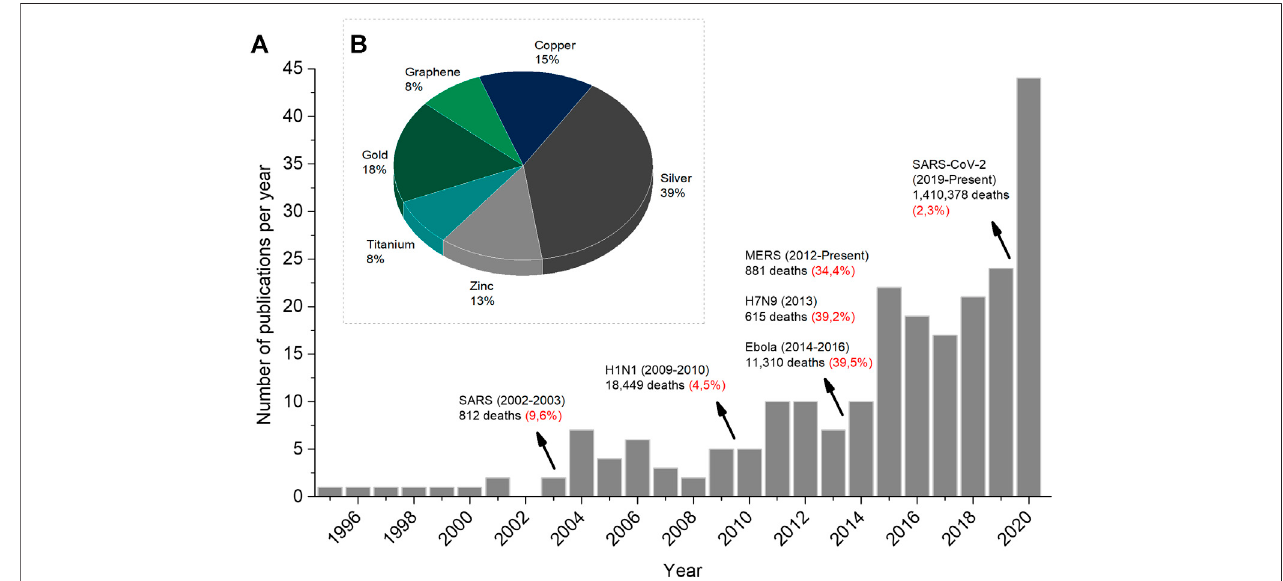
FIGURE2|(A) Numberofpublicationsdevotedtoantiviralmaterialswherethemortalityrate(inred)ofmajorvirusdiseaseoutbreaksworldwideinthelast25years is pointed out (B) Main antiviral materials under study in the last 5 years. The search is the same as described in Figure 1 but including the antiviral metallic and ceramic materials ’ name. Search performed on November 26,